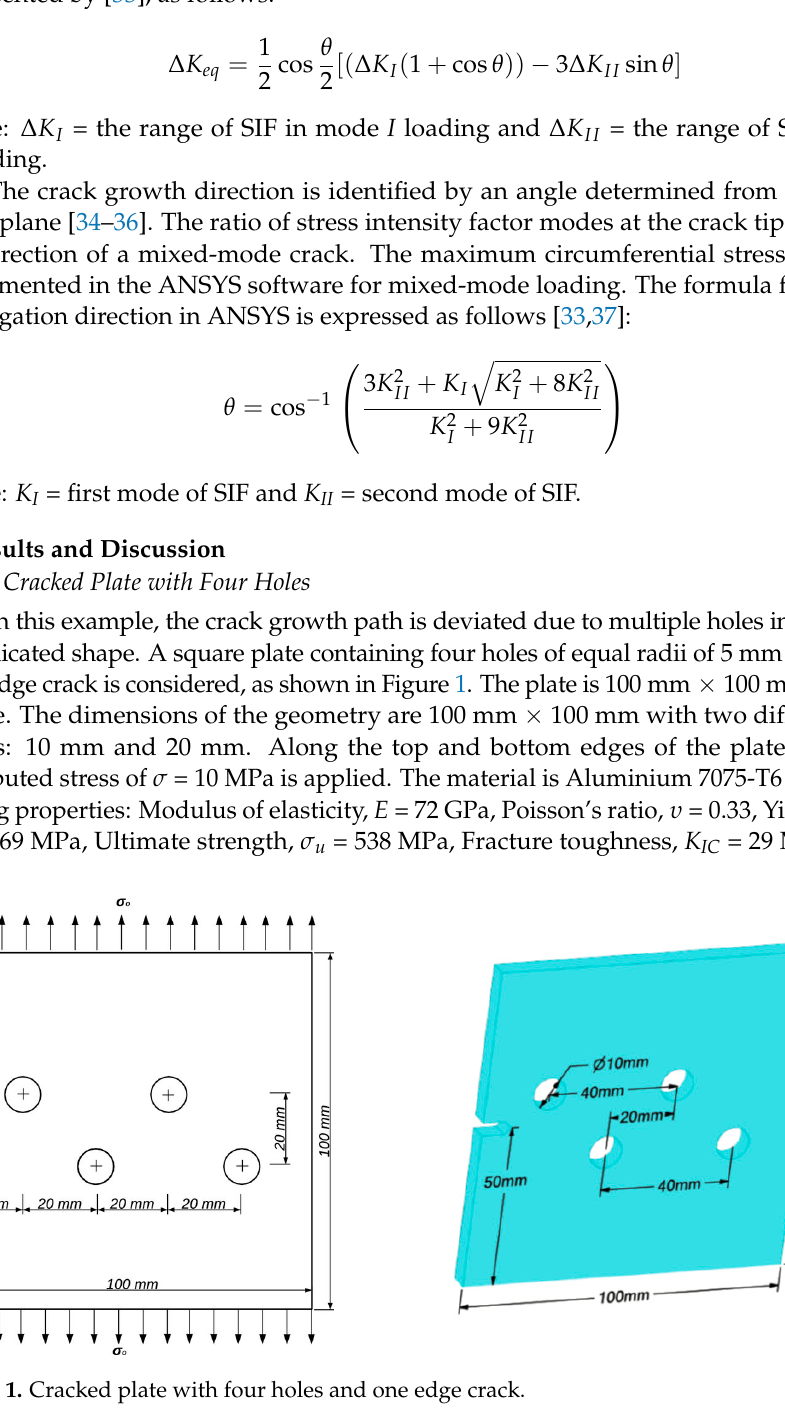
Figure 1. Cracked plate with four holes and one edge crack. Figure 2 depicts the initial mesh generated by Ansys, which had a 1 mm element size and generated 693,495 nodes and 453,855 elements for a 10 mm (Figure 2a)